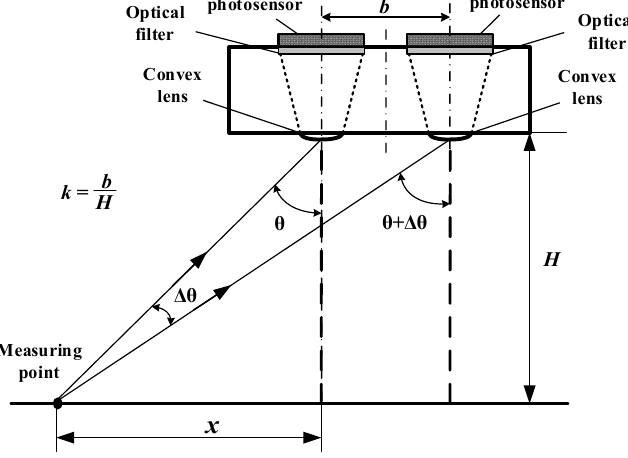
Figure 1. Layout of active light source.